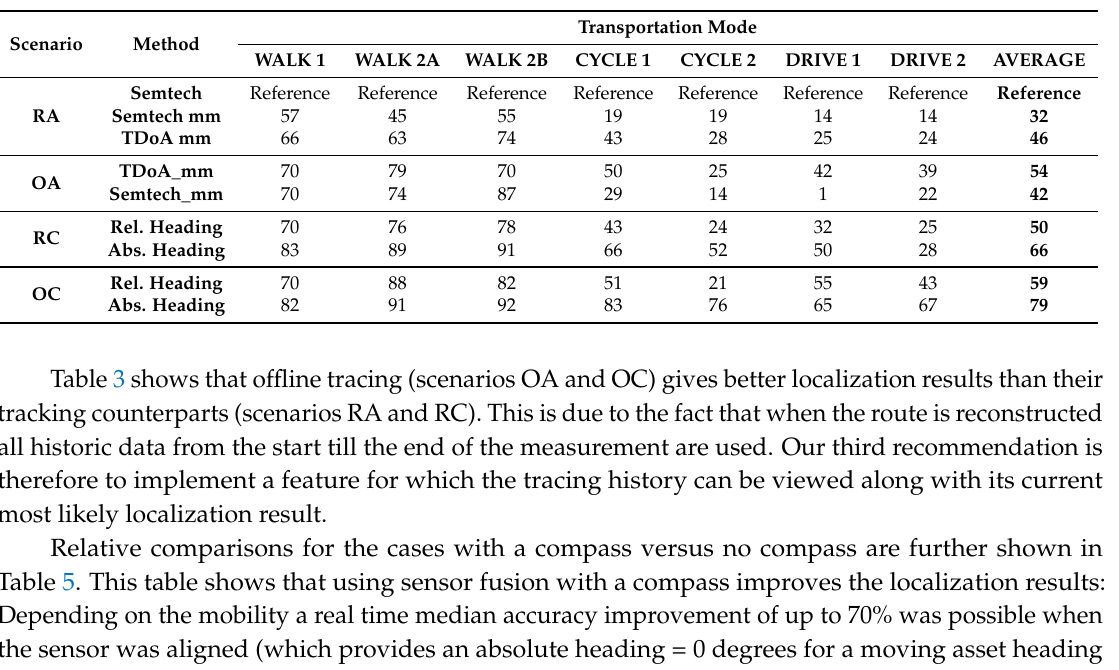
Table 4. Percentual reduction in median positioning error for the various scenarios, methods, and